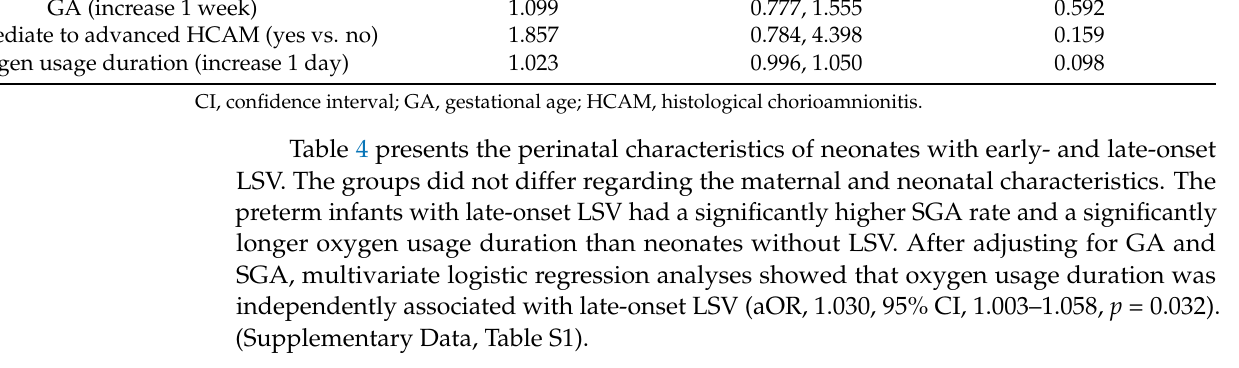
Table 4. Perinatal characteristics of the early-onset lenticulostriate vasculopathy (LSV), late-onset LSV, and non-LSV groups, and comparisons between the groups regarding clinical